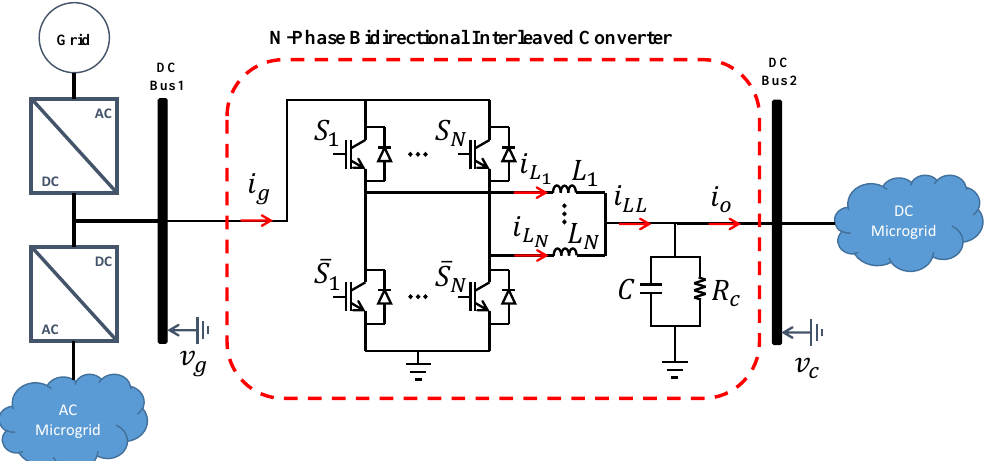
Figure 1. Hybrid microgrid topology that uses the interleaved converter as a power interface.